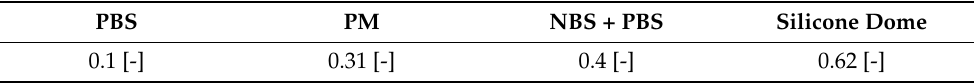
Table 3. Normalized stroke reached with different bias elements: positive-rate biasing spring